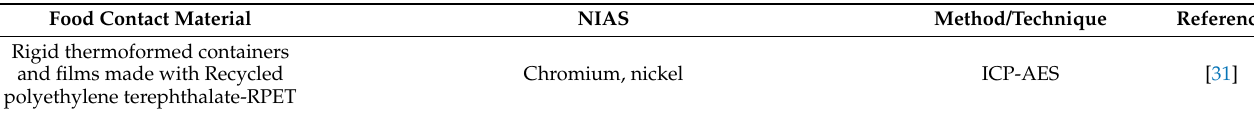
Recycled pellets obtained from post-consumer low-density polyethylene (PC-LDPE) and high-density polyethylene (PC-HPDE)